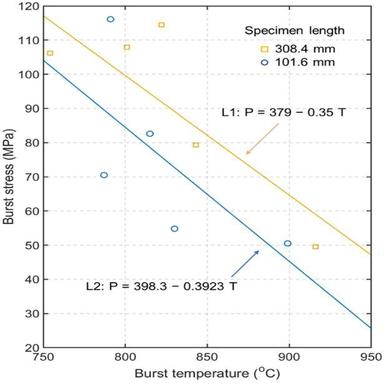
Comparison burst pressure and burst temperature results of 308.4 mm and 101.6 mm specimens. Noting that pressure and temperature were not control parameters in this study.